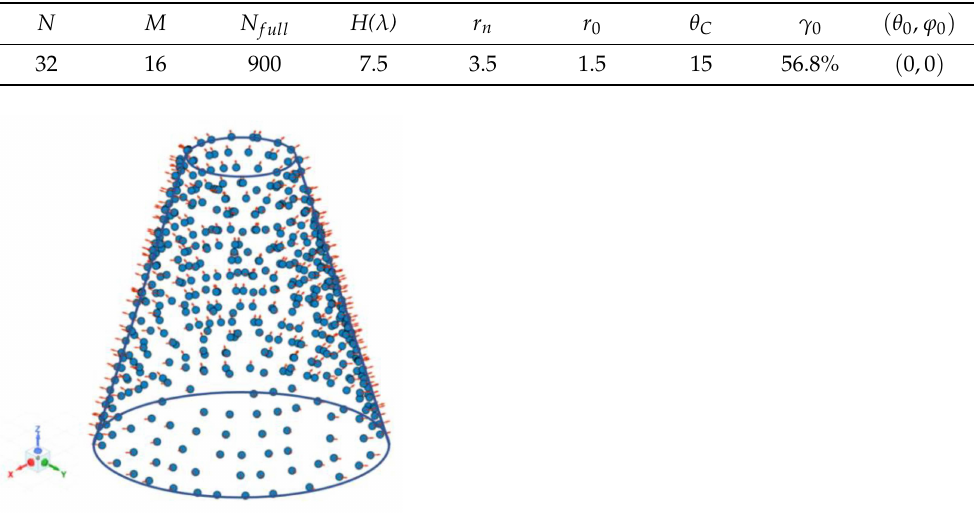
Figure 10. The geometry of sparse array example 2.